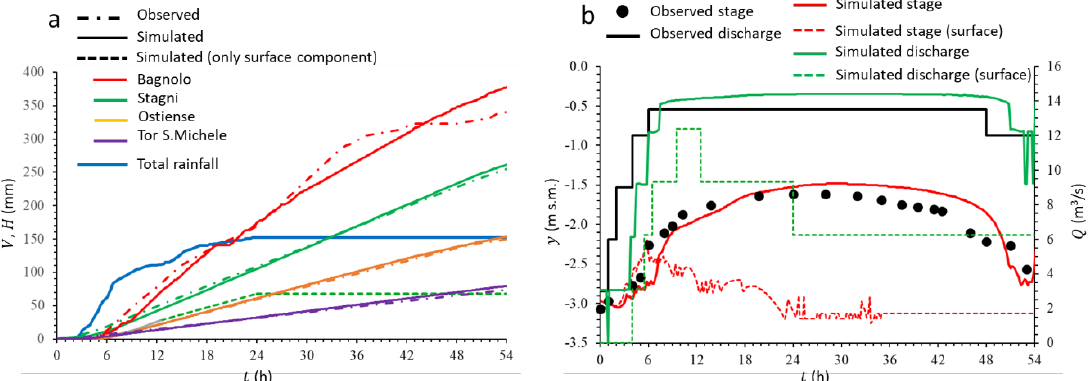
Figure 5. Event of 31 January 2014, comparison between observations (dot-dashed lines) and simulations (solid lines) at the pumping stations. ( a ) Water volumes (per unit catchment area) pumped and the total rainfall; ( b ) water levels and flow rates at the pumping stations at the Stagni pumping station. The simulated results for the Stagni station pertaining to the sole surface component are represented by dashed lines.